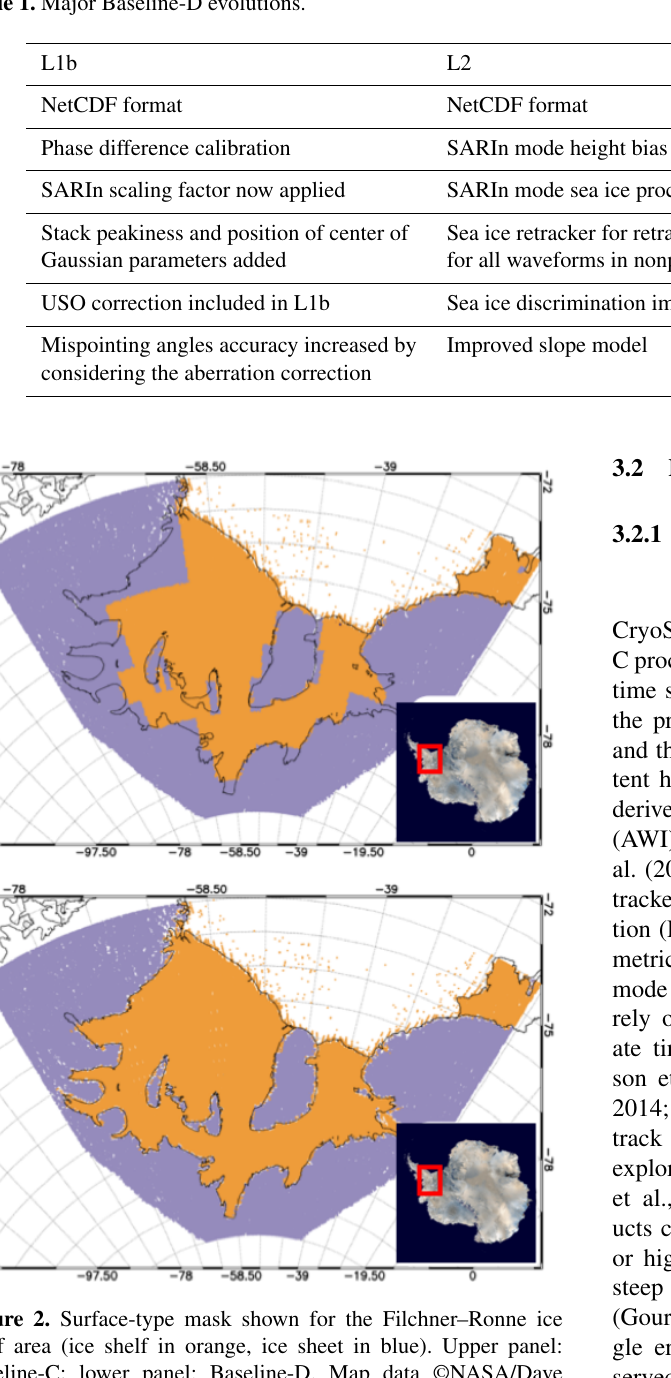
Table 1. Major Baseline-D evolutions.